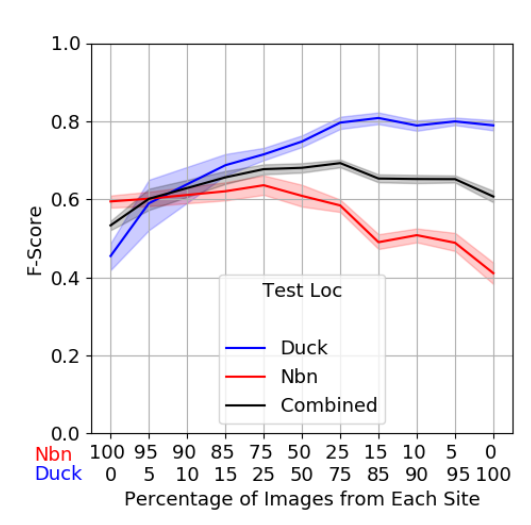
Figure 8. F-scores for CNN ensembles trained with varying ratios of training data and tested at Narrabeen (red), Duck (blue) and the combined data set (black). The shading represents the 95% confidence interval for the ensembles for each test. The x-axis shows the number of training images per class per